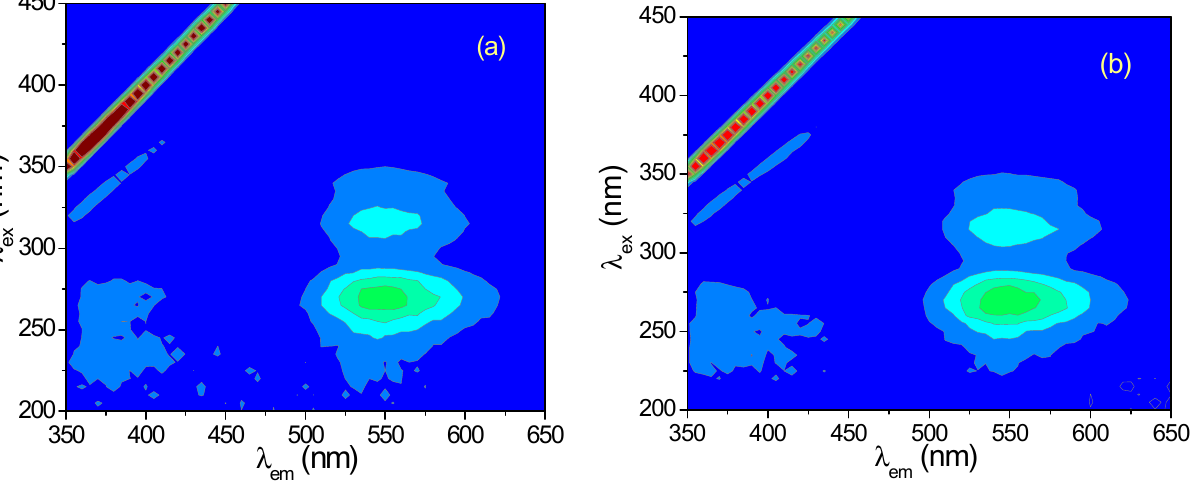
Figure 2. 3D fluorescence spectra of CH ( a ) and ECH ( b ) in acidic methanol solutions. c CH = 0.133 μ g·mL − 1 , c ECH = 0.181 μ g·mL − 1 , c HCl = 0.01 M, contour interval: 50.